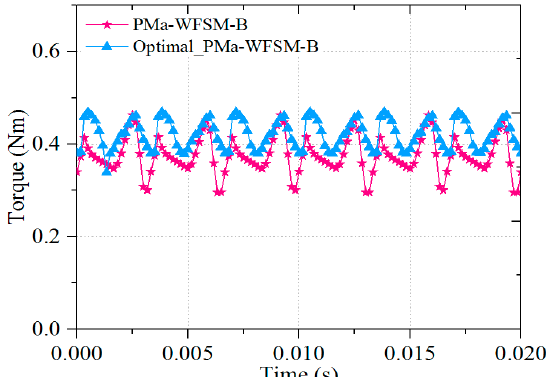
Figure 13. The electromagnetic torques of proposed and optimal model.